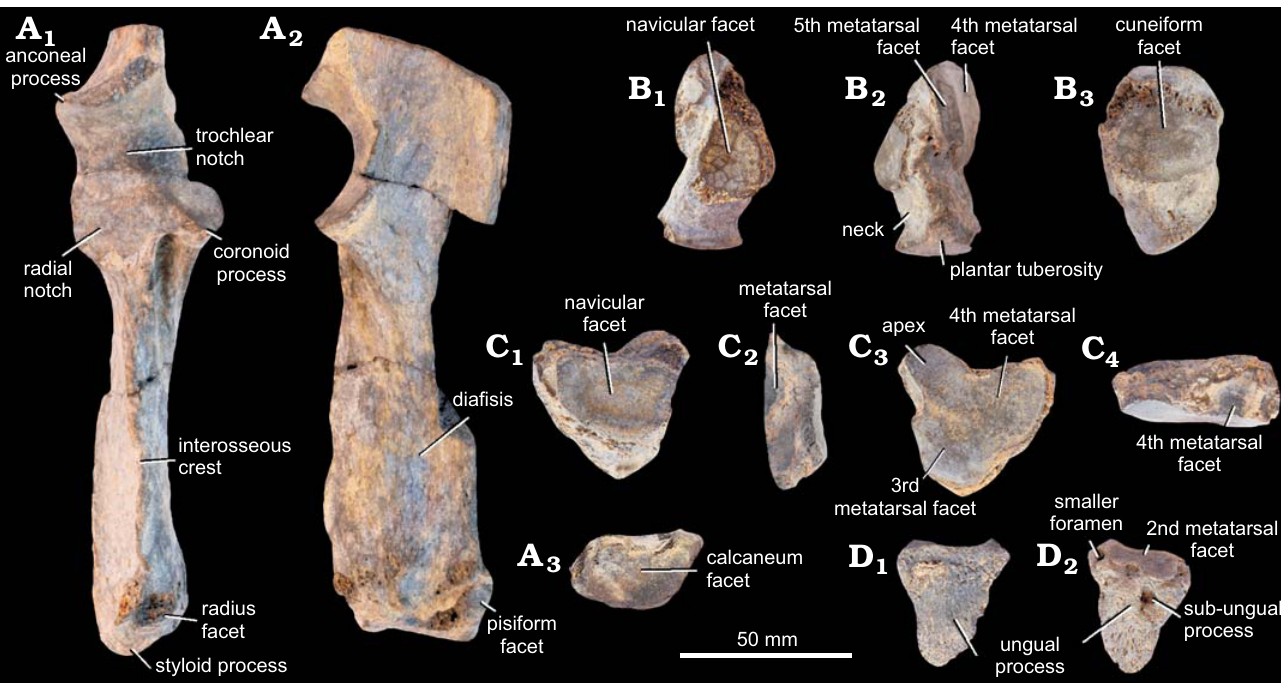
Fig. 7. Skeleton of new specimen (MPM-PV 17410) of Palaehoplophorus meridionalis Ameghino, 1904 from Meseta de Guenguel, Patagonia, Río Mayo Formation, Serravallian–Tortonian, middle-late Miocene. A . Ulna in anterior (A 1 ), latero-external (A 2 ), and distal (A 3 ) views; B . Cuboid in latero-internal (B 1 ), antero-ventral (B 2 ), and dorso-lateral (B 3 ) views. C . Ectocuneiform in proximal (C 1 ), distal (C 2 ), latero-internal (C 3 ), and latero-external (C 4 ) views. D . Ungual phalanx in dorsal (D 1 ) and ventral (D 2 )